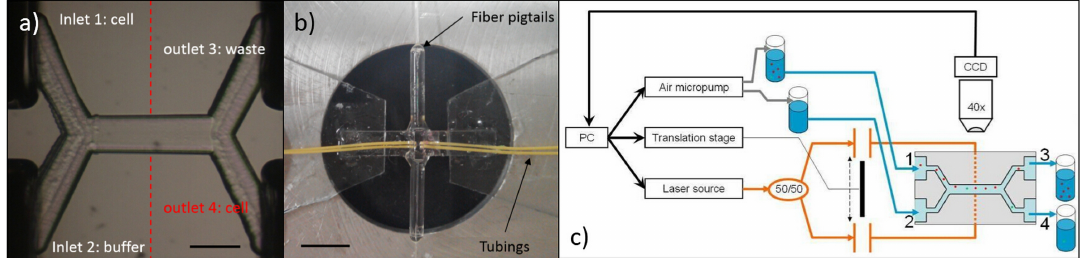
Figure 16. Active cell sorting chip design. ( a ) Microscope image of the internal structure of the cell sorting microchip. Scale bar: 100 µm; ( b ) The finished chip with fibers pigtailed and tubing connected is very compact. Scale bar: 1 cm; ( c ) Schematic of the experimental setup. Figure reproduced from Reference [24] with permission from Royal Society of